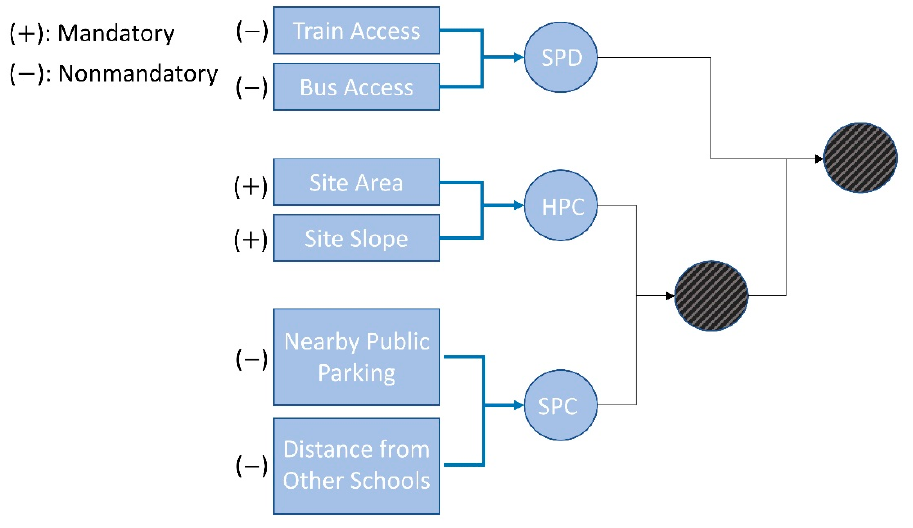
Figure 2. Sample LSP aggregation structure for selecting a location for a new college.